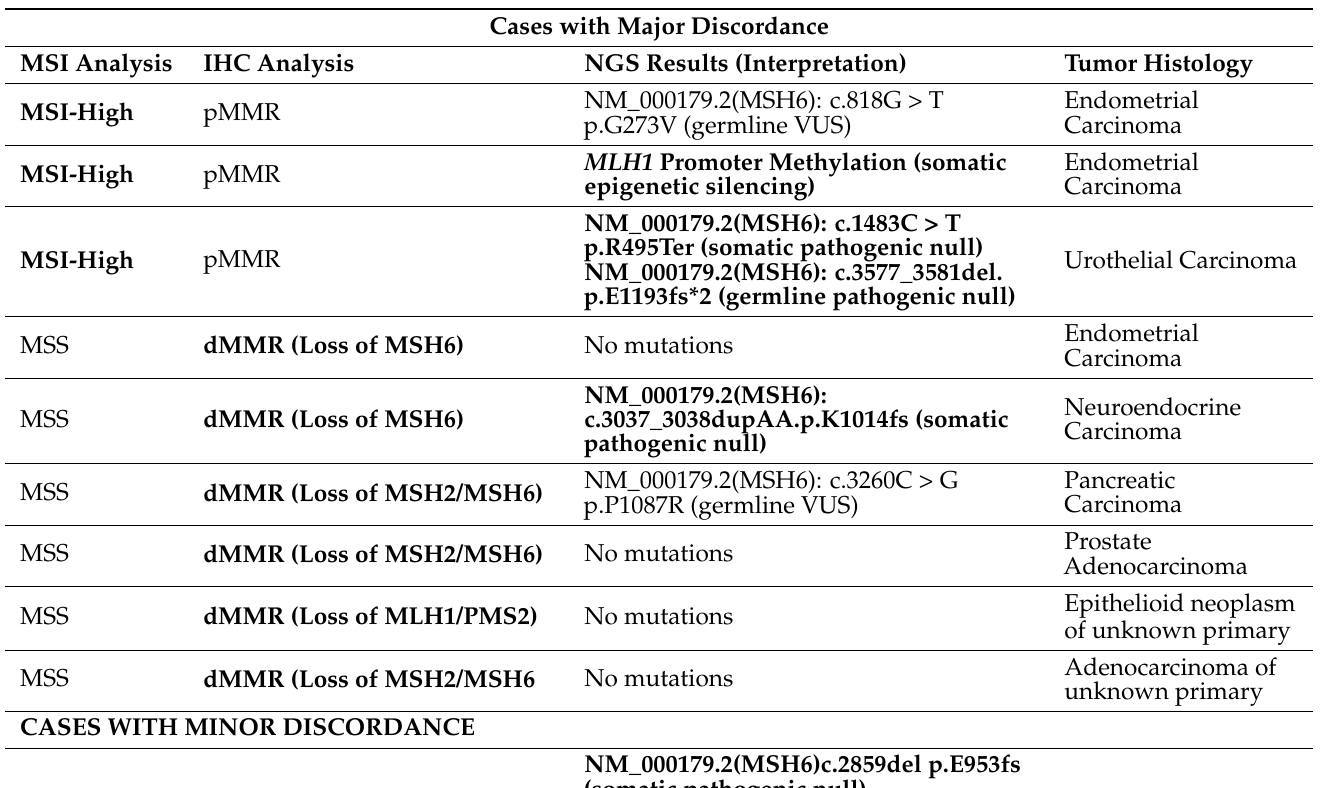
Table 3. Cases with major and minor